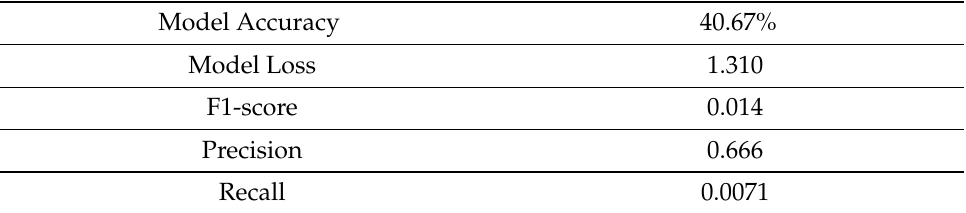
Table 11. Results of LSTM model with commit messages and code metrics as